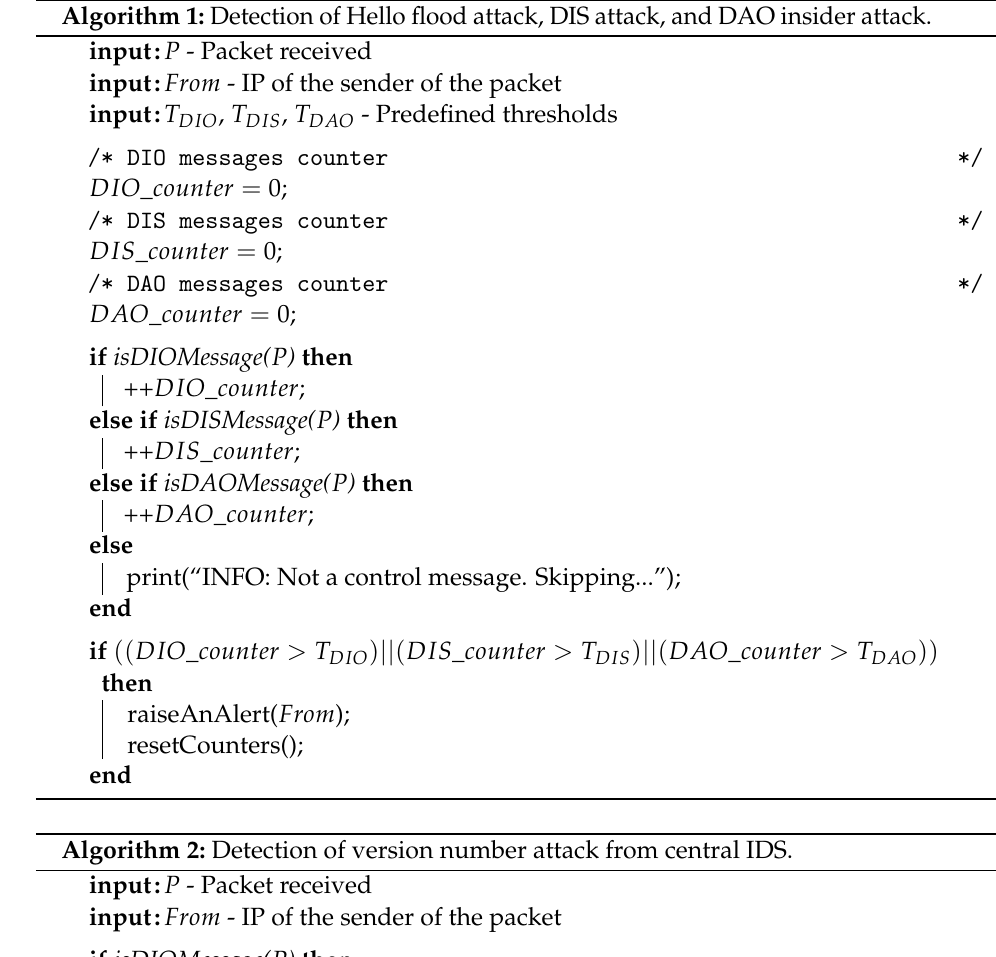
Algorithm 1: Detection of Hello flood attack, DIS attack, and DAO insider attack.